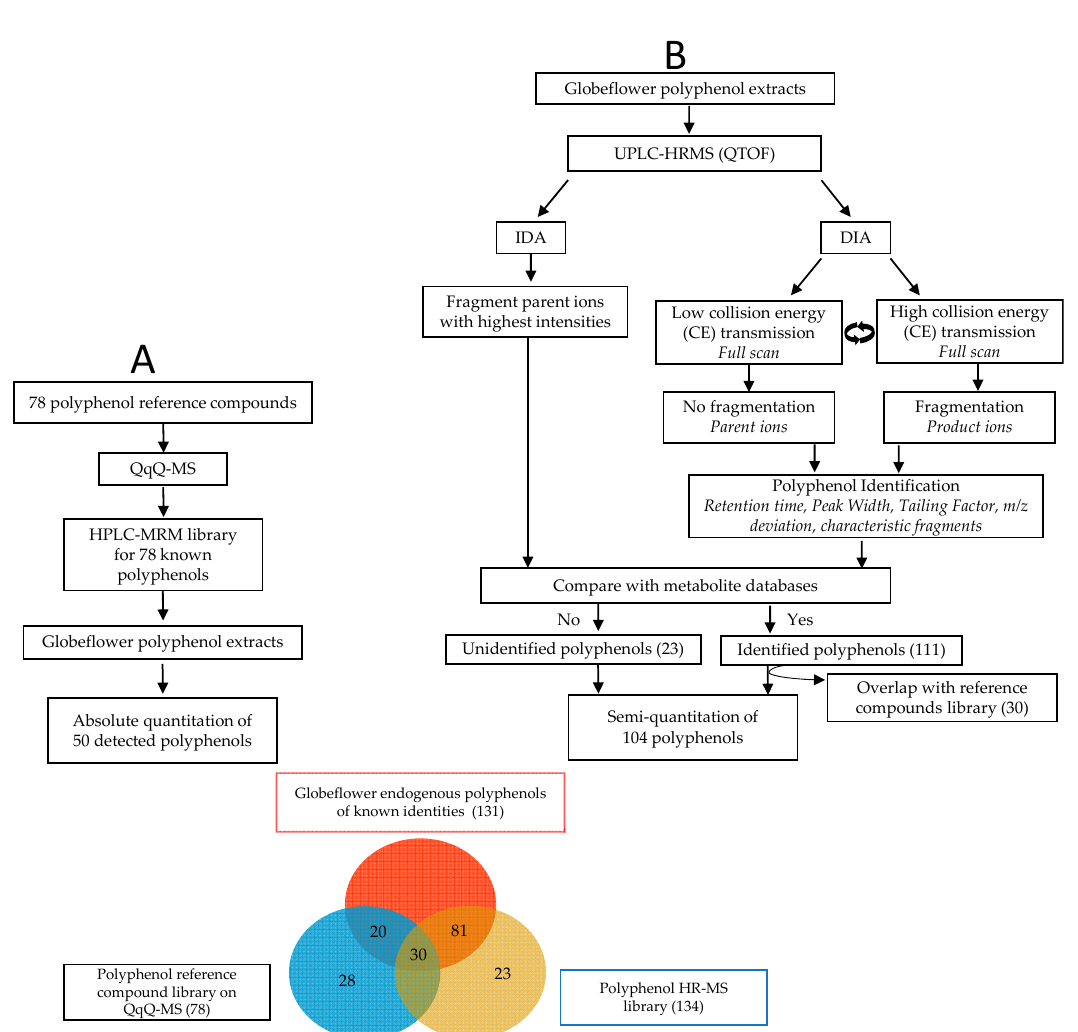
Figure 1. Schematic diagram illustrating combination of ( A ) using HPLC-QqQ (MRM) and ( B ) using UPLC-QTOF (IDA and DIA) approaches for identification and quantification of polyphenols in globeflowers. HPLC, high-performance liquid chromatography; QqQ, tandem triple quadrupole; MS, mass spectrometry; HR, high resolution; UPLC, ultra-performance liquid chromatography; QTOF, tandem quadrupole time of flight.